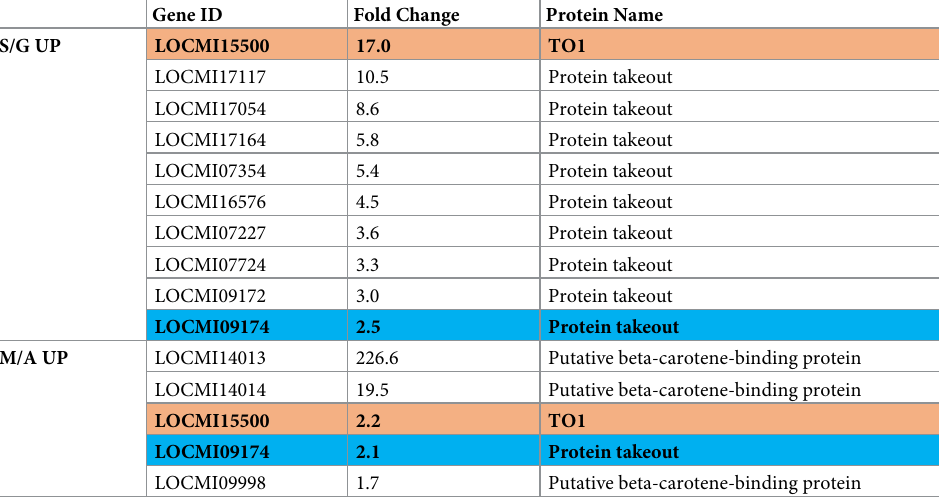
Table 2. Gene expression change of hemolymph juvenile hormone binding category. Gene ID Fold